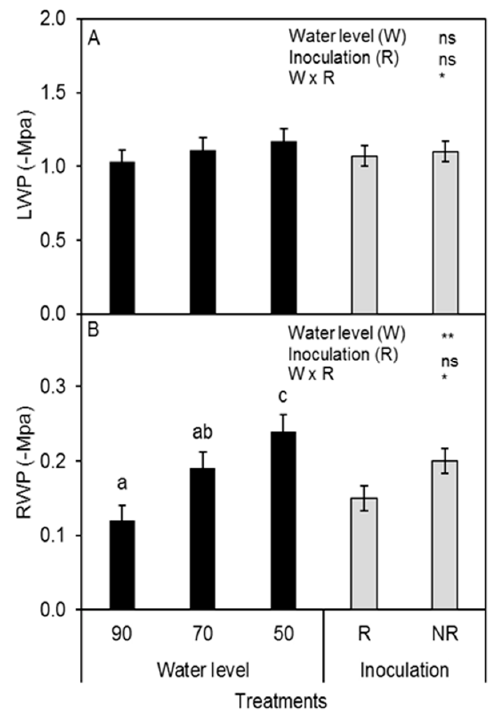
Figure 4. ( A ) Leaf water potential (LWP) and ( B ) root water potential (RWP) of cowpea under different soil water regimes (90%, 70%, and 50% of SWHC) and rhizobia inoculation. Values are means + SE (n = 8 for 90%, 70%, and 50% of SWHC treatments and n = 12 for R and NR treatments). Different letters indicate significant differences in the experimental factor at p < 0.05 according to Duncan’s multiple range test.